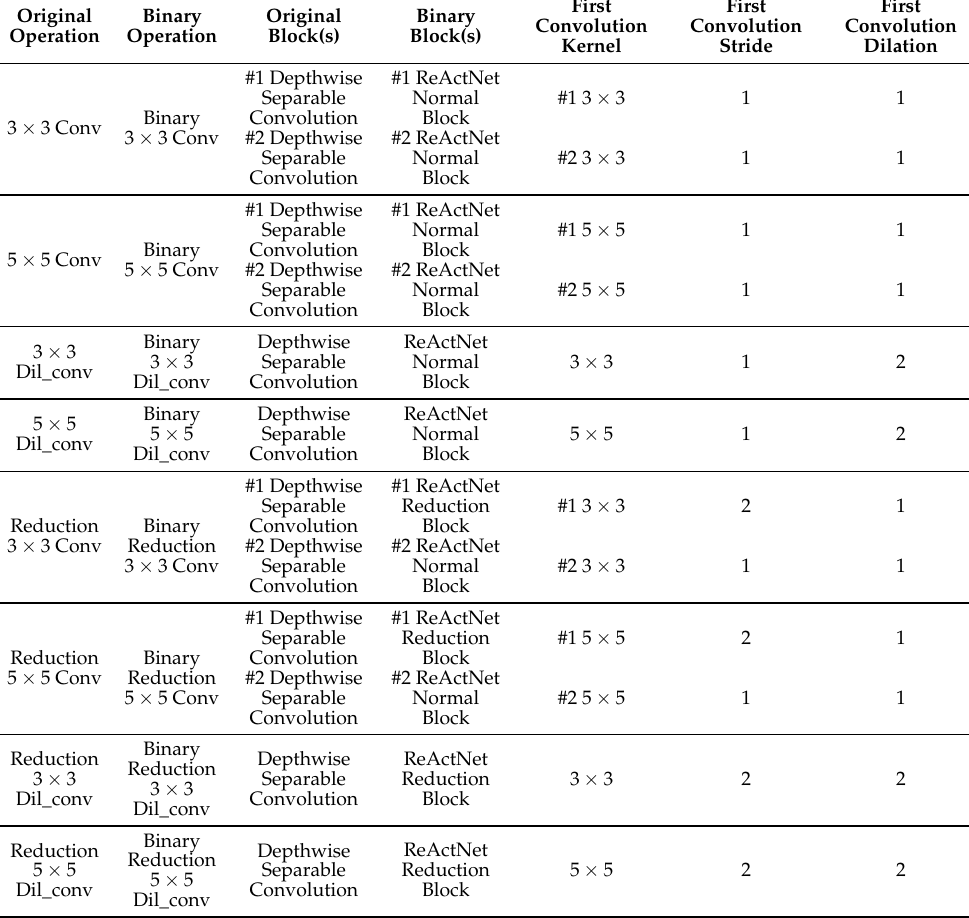
Table 2. The details of the modification and binarization of